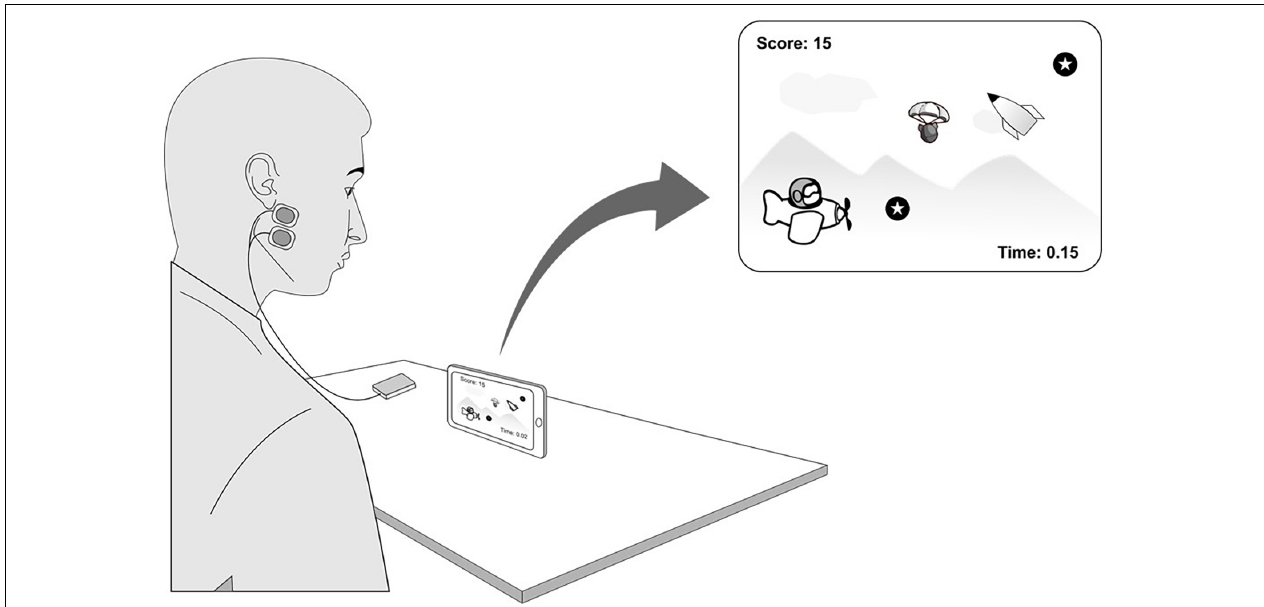
FIGURE 1 | Showing experimental setup with a participant with bipolar electrodes placed on the masseter muscle, the electromyography device and android mobile phone. Blow-up: a screenshot of the exergame with the coins (game scores) and obstacles (game life). The electromyographic device could communicate with the mobile videogame via Bluetooth in response to the electromyographic activity of the masseter muscle during clenching.